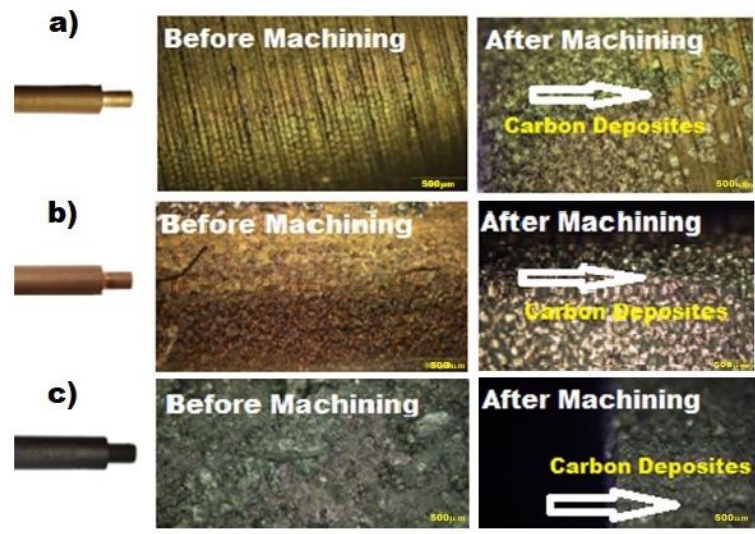
Figure 31. Microstructural changes of electrode material ( a – c ). Change in surface and subsurface properties of the electrode material is found during machining of Si-Al (13 wt.% Si) alloy matrix reinforced with ZrO 2 particulates composites due to increase in temperature exceeding more than 10,000 ◦ C and rapid